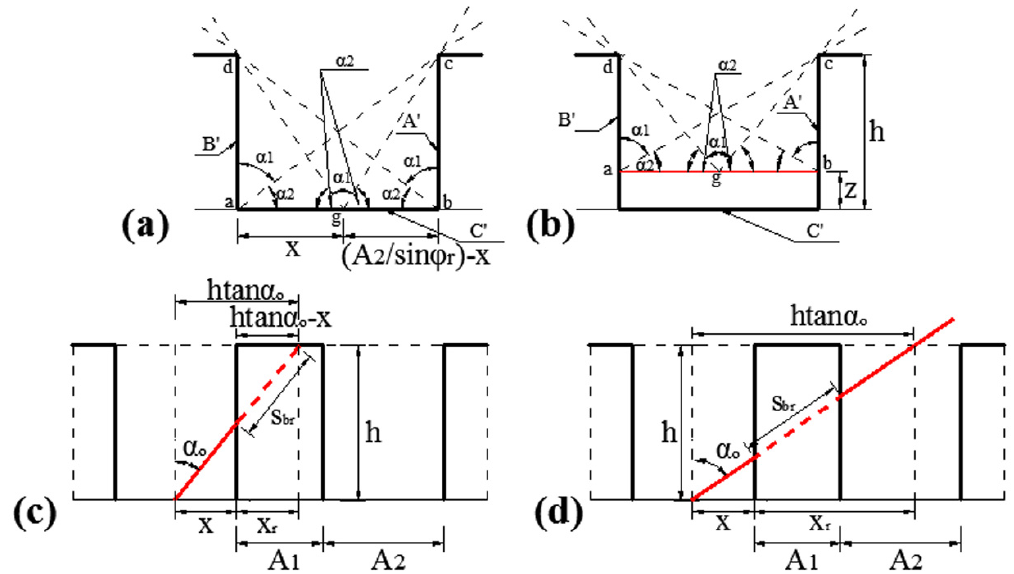
Figure 3. Sketch of the between-row area. ( a ) Angle relationship between the escape surface and the bottom of the between-row area. ( b ) Angle relationship between the escape surface and the z position of the between-row area. ( c ) Geometric relationship for the viewing probability of the between-row soil when x r ≥ A 1 . ( d ) Geometric relationship for the viewing probability of the between-row soil when x r < A 1 . Here, α o is the inclined angle projected in the perpendicular plane in the viewing direction, α 1 is the openness angle of the between-row area, and α 2 is the nonopenness angle of the between-row area. s br is the path length of the light of the canopy closure for the between-row soil observed, ϕ r is the row azimuth angle, A 1 is the row width, A 2 is the between-row distance, and h is the canopy height.